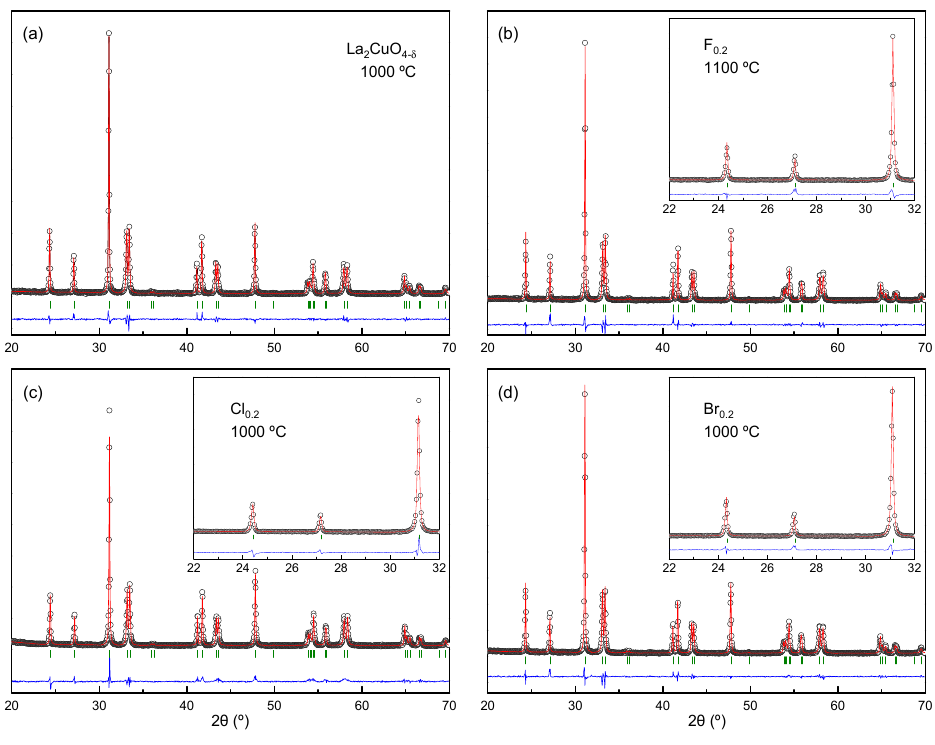
Figure 3. Rietveld refinement plots of ( a ) La 2 CuO 4 − δ , ( b ) F 0.2 , ( c ) Cl 0 . 2 and ( d ) Br 0.2 sintered at 1000 or 1100 ◦ C for 1